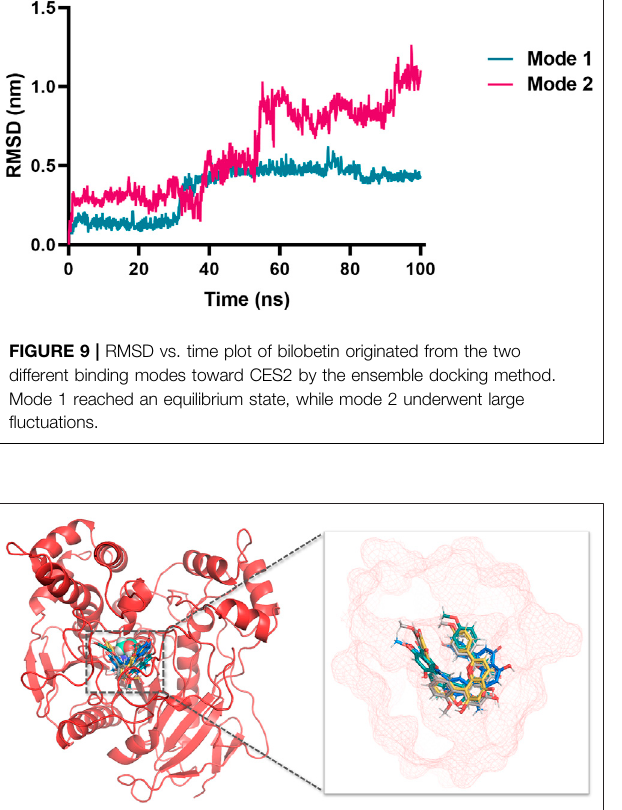
FIGURE10| Alignedbindingposesoffourbi fl avonesagainstCES2.The catalytic residue Ser228 was shown in cyan spheres in aerial view, ginkgetin, bilobetin,sciadopitysin,isoginkgetinweredepictedwithblue,yellow,grayand green, respectively. The active cavity of CES2 was displayed in red